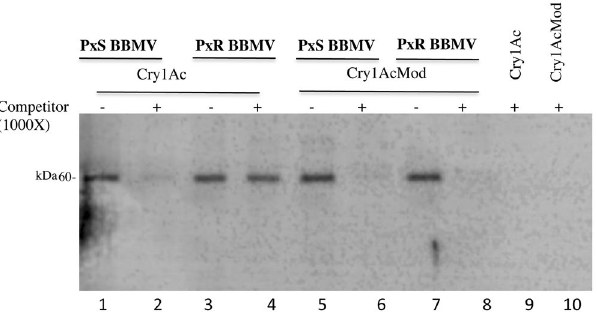
Figure 1. Total binding and non-specific binding of Cry1Ac and Cry1AcMod toxins to Plutella xylostella . Total binding and non-specific binding of biotinylated-Cry1Ac and Cry1AcMod toxins to BBMV isolated from P. xylostella susceptible Geneva 88 (PxS) and resistant NO-QAGE (PxR) populations. Lanes with negative symbol ( − ) represent total binding in absence of competitor and lanes with positive symbol ( + ) represent non-specific binding in the presence of 1000X unlabeled competitor. Lanes 1, 2, 3, and 4 are Cry1Ac labeled toxin incubated with BBMV from PxS (lanes 1 and 2) or PxR (lanes 3 and 4). Lanes 5, 6, 7 and 8 are Cry1AcMod labeled toxin incubated with BBMV from PxS (lanes 5 and 6) or PxR (lanes 7 and 8). Lane 9 and 10 are precipitation controls of labeled Cry1Ac (lane 9) or Cry1AcMod (lane 10) incubated with excess of unlabeled toxin without BBMV.